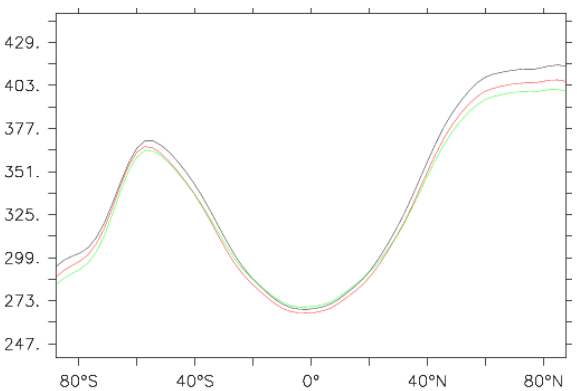
Fig. 4. Zonal and time average (January–December 1998) of total column ozone (DU) for S-E4CHEM (black), S- MECCA(E4CHEM) (red) and S-MECCA(EVAL) (green).